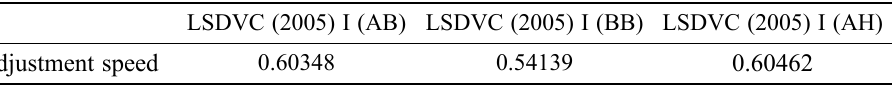
Table 6. Debt adjustment